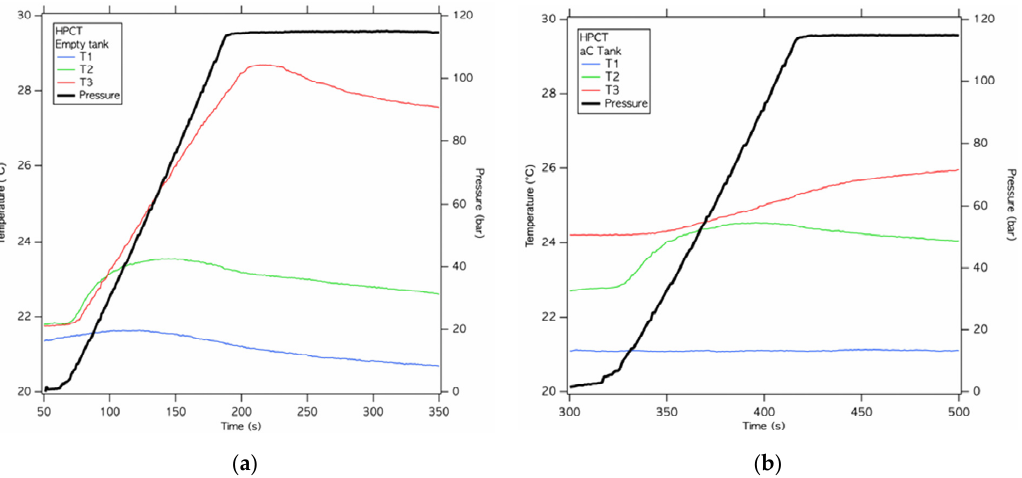
Figure 9. ( a ) H 2 adsorption on active carbon NUCHAR SA. H 2 pressure and temperatures for a 1-liter reservoir filled with a constant 50 STP liters/min flow in empty reservoir; ( b ) H 2 adsorption on active carbon NUCHAR SA. H 2 pressure and temperatures for a 1-liter reservoir filled with a constant 50 STP liters/min flow in SSM-filled reservoir.